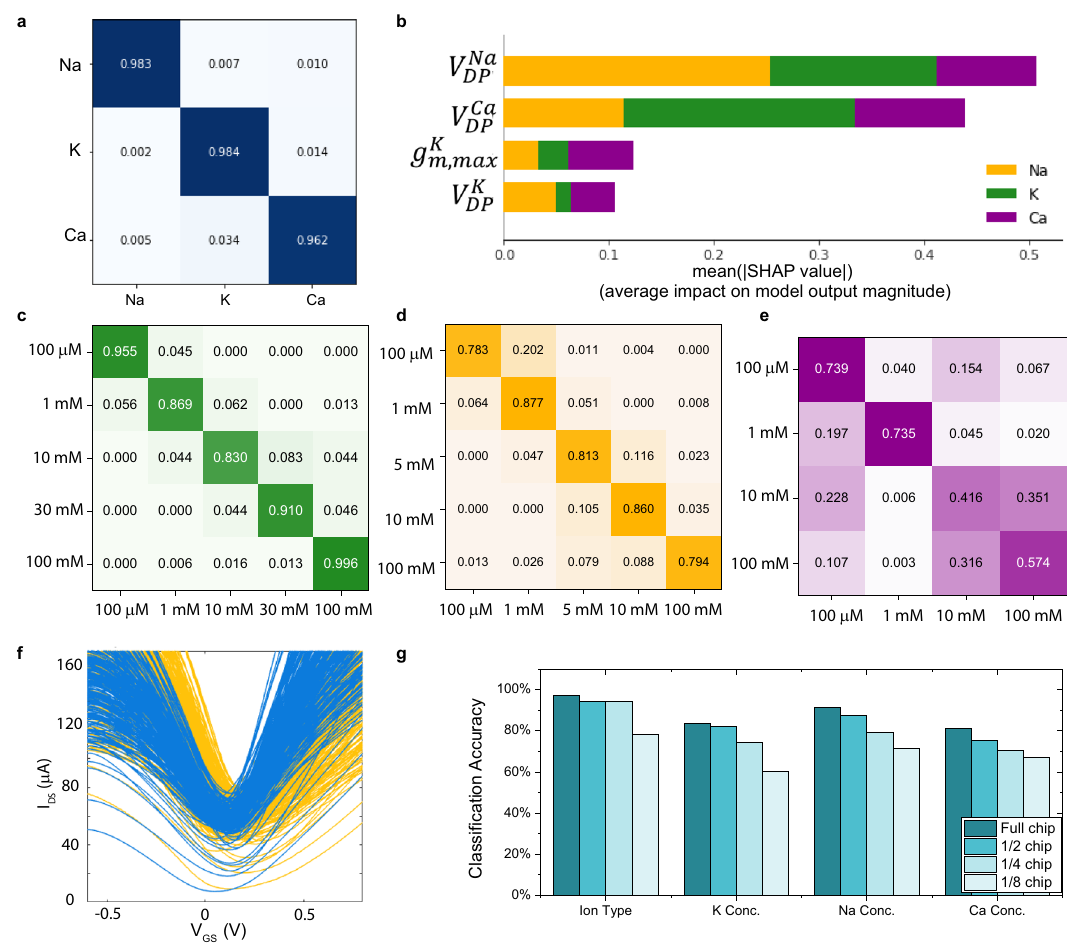
Fig. 4 | Random Forest Model using data from highly integrated sensing chip. a Confusion matrix of the ion-type classi fi er. b Top four SHAP (Shapley Additive exPlanations) values for the ion-type classi fi er. V Na DP , V Ca DP and V K DP represent the Dirac Points of devices with Na + ISM, Ca 2+ ISM, and K + ISM functionalization respectively. g K m ,max represents the maximum slope of devices with K + ISM